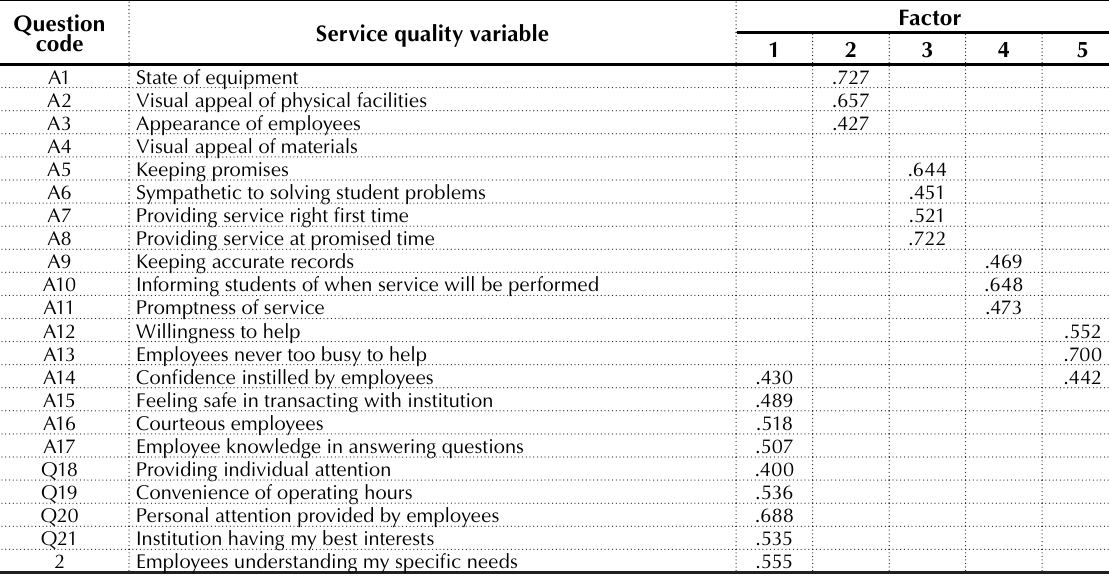
Table 4. Rotated factor matrix service quality Question code